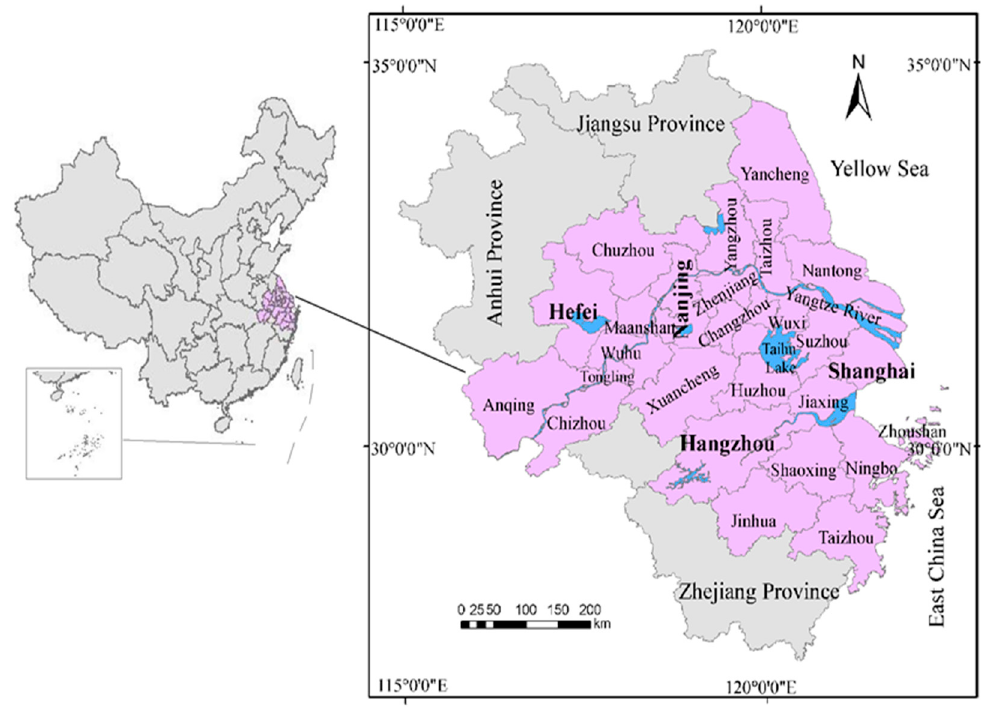
Figure 1. The location of the Yangtze River Delta in China.